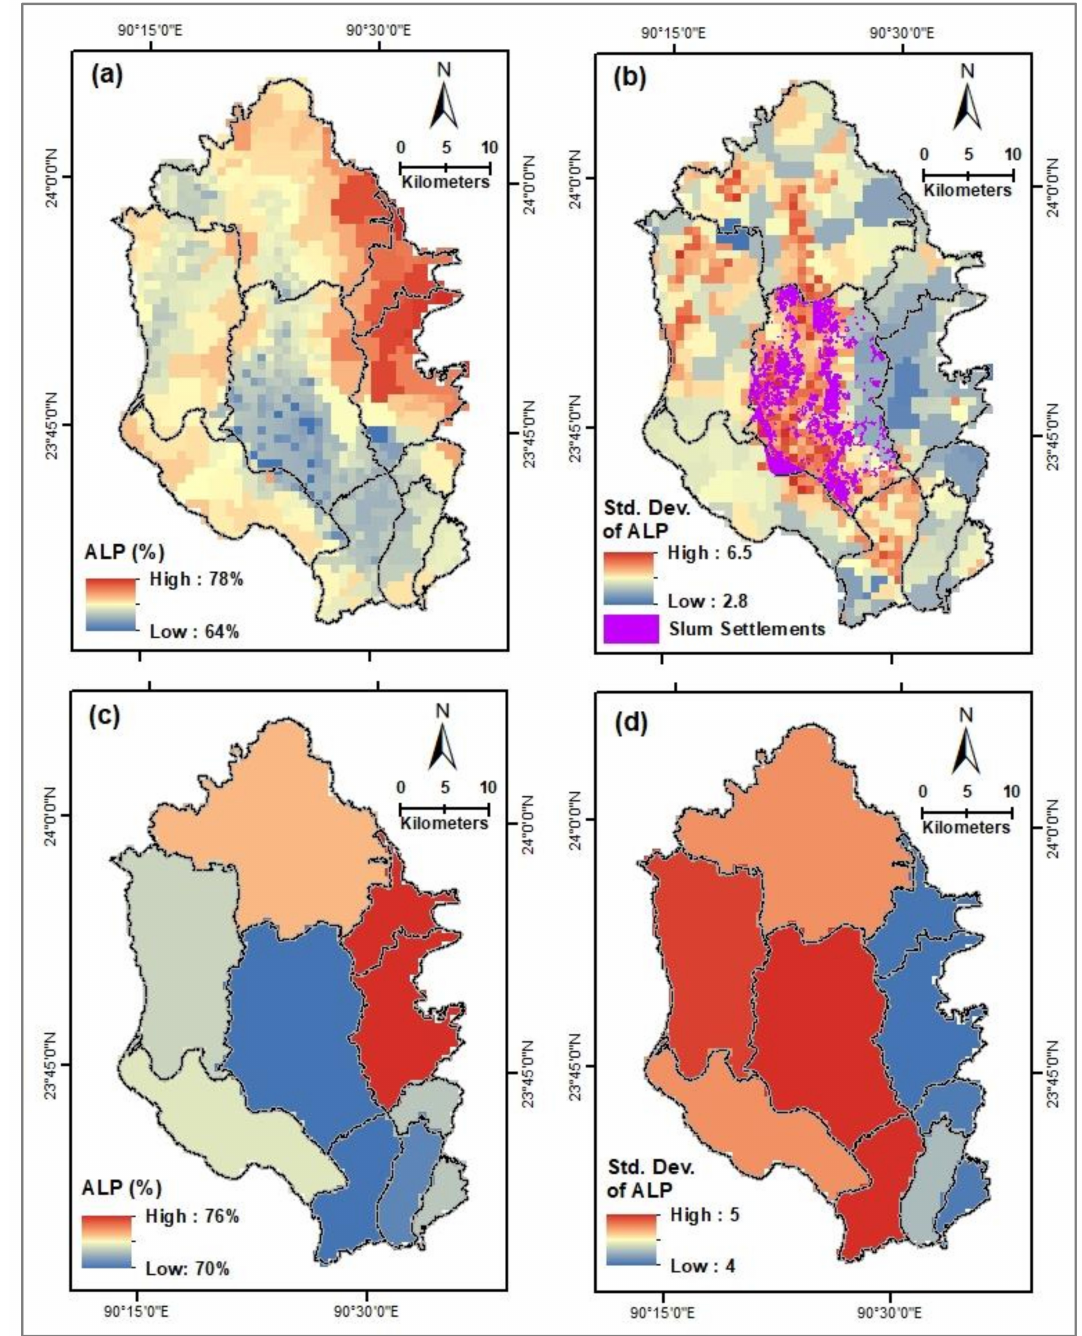
Figure 19. ( a ) Spatial distribution of the average likelihood of poverty (ALP) (i.e., the average probability of living on less than $2.50 / day) of 2013 [62]; ( b ) slum settlement areas (derived from Gruebner et al. [63]) superimposed on the standard deviation (Std. Dev.) of the average likelihood of poverty (ALP) mapping of 2013 [62]; ( c ) sub-district-wise spatial distribution of the average likelihood of poverty (ALP); ( d ) sub-district-wise spatial distribution of the standard deviation (Std. Dev.) of the average likelihood of poverty